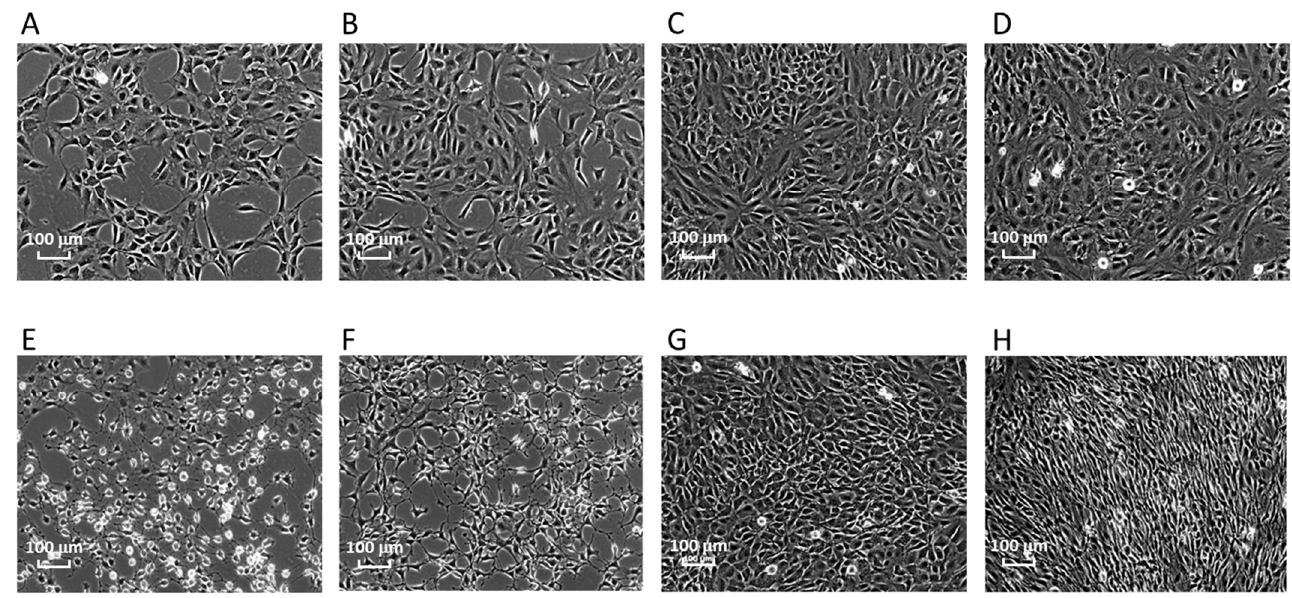
Figure 1. Morphological changes of Bhas 42 cells after treatment with TPA. ( A ) Solvent control, 1 h; ( B ) solvent control, 6 h; ( C ) solvent control, 24 h; ( D ) solvent control, 8 days; ( E ) TPA, 1 h; ( F ) TPA, 6 h; ( G ) TPA, 24 h; ( H ) TPA, 8 days.